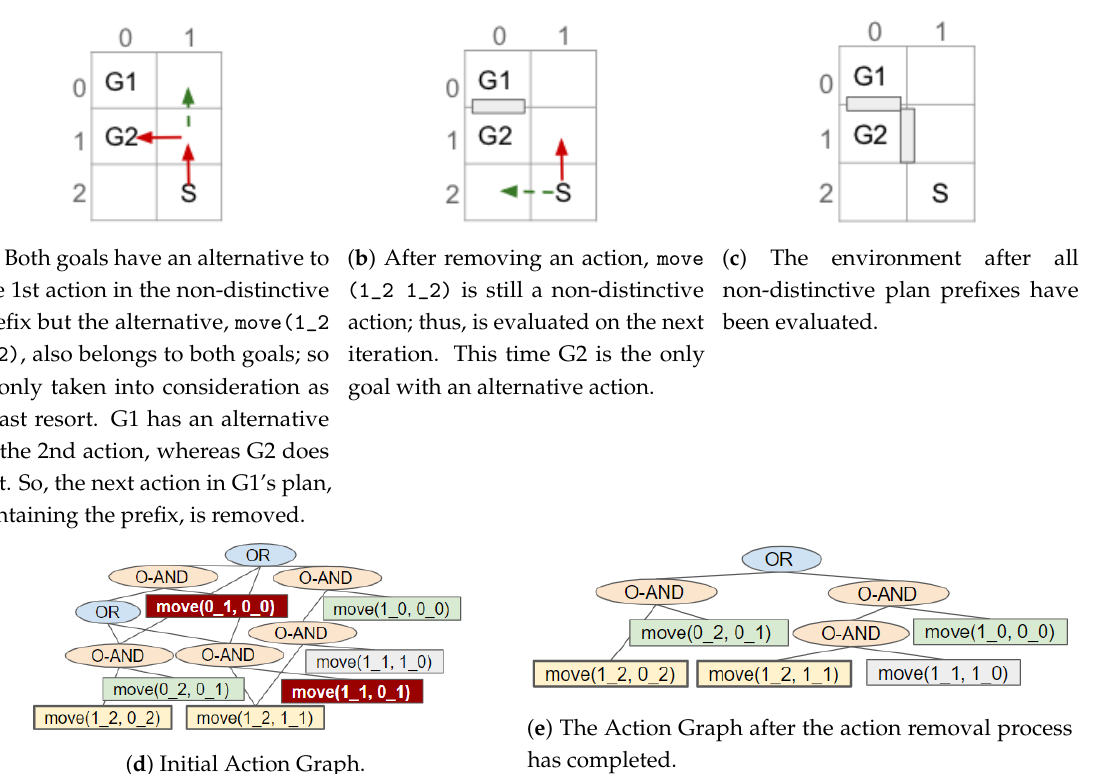
Figure 12. Example of ACD reduction, when only a subset of the goals have an alternative action, to an action in the worst non-distinctive plan